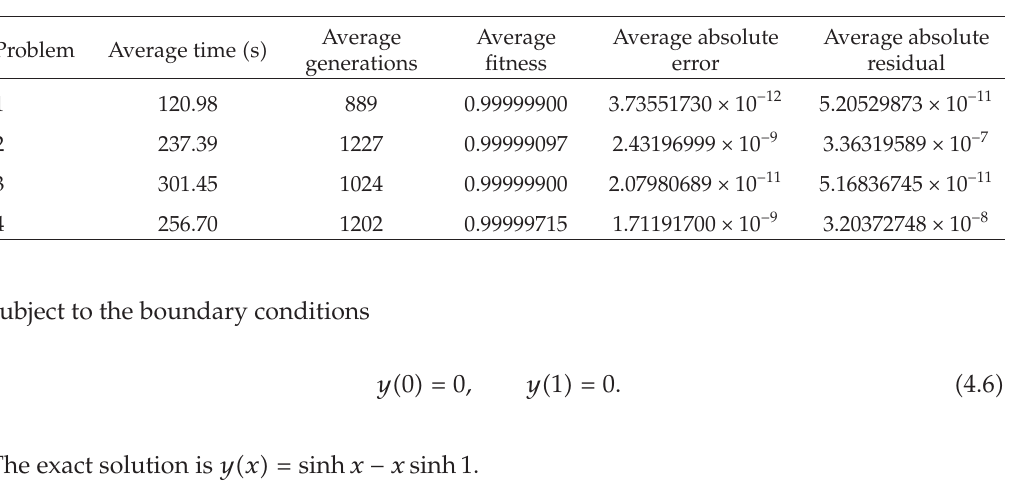
Table 2: Convergence data of the four